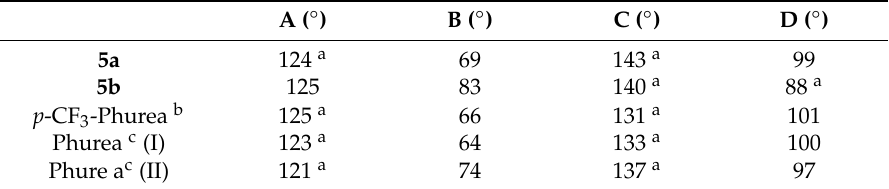
Table 1. Comparison of cone conformations: Dihedral angles between corresponding aryl planes of the calixarene cones (A, B, C and D) and the mean planes of the bridging methylene carbon atoms for various dihomooxacalix[4]arenes.